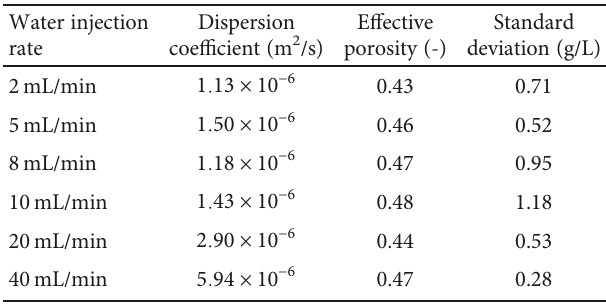
Table 3: Parameter optimization and error analysis of reverse gravity